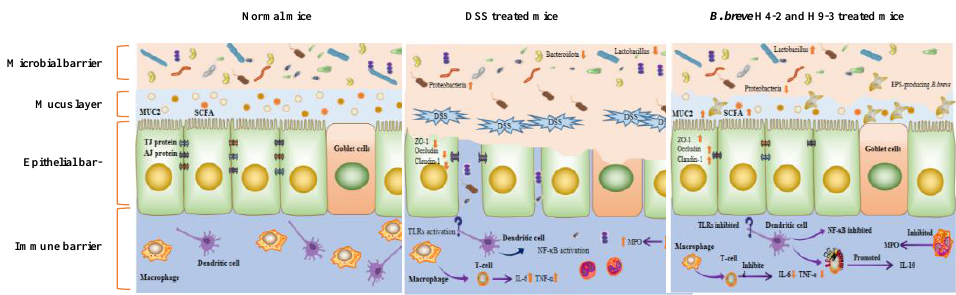
Figure 11. The schematic of improvement effects of EPS-producing B. breve on mice colitis.